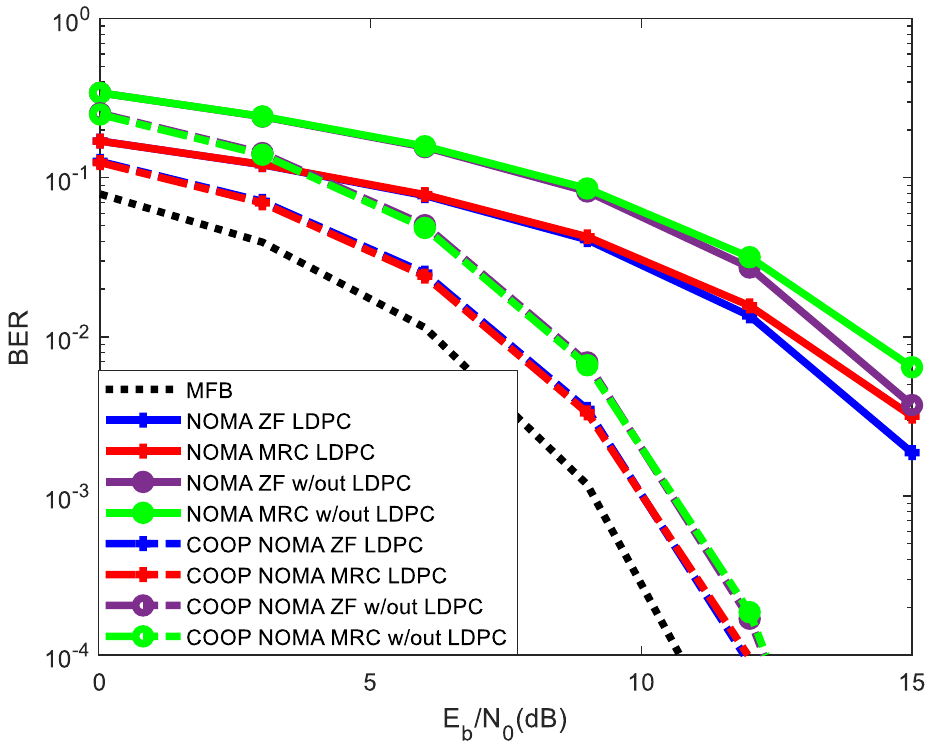
Figure 6. Results for 4 NOMA users with powers [1, 0.5, 2, 4], with 8 × 64 MIMO (with and without LDPC codes).